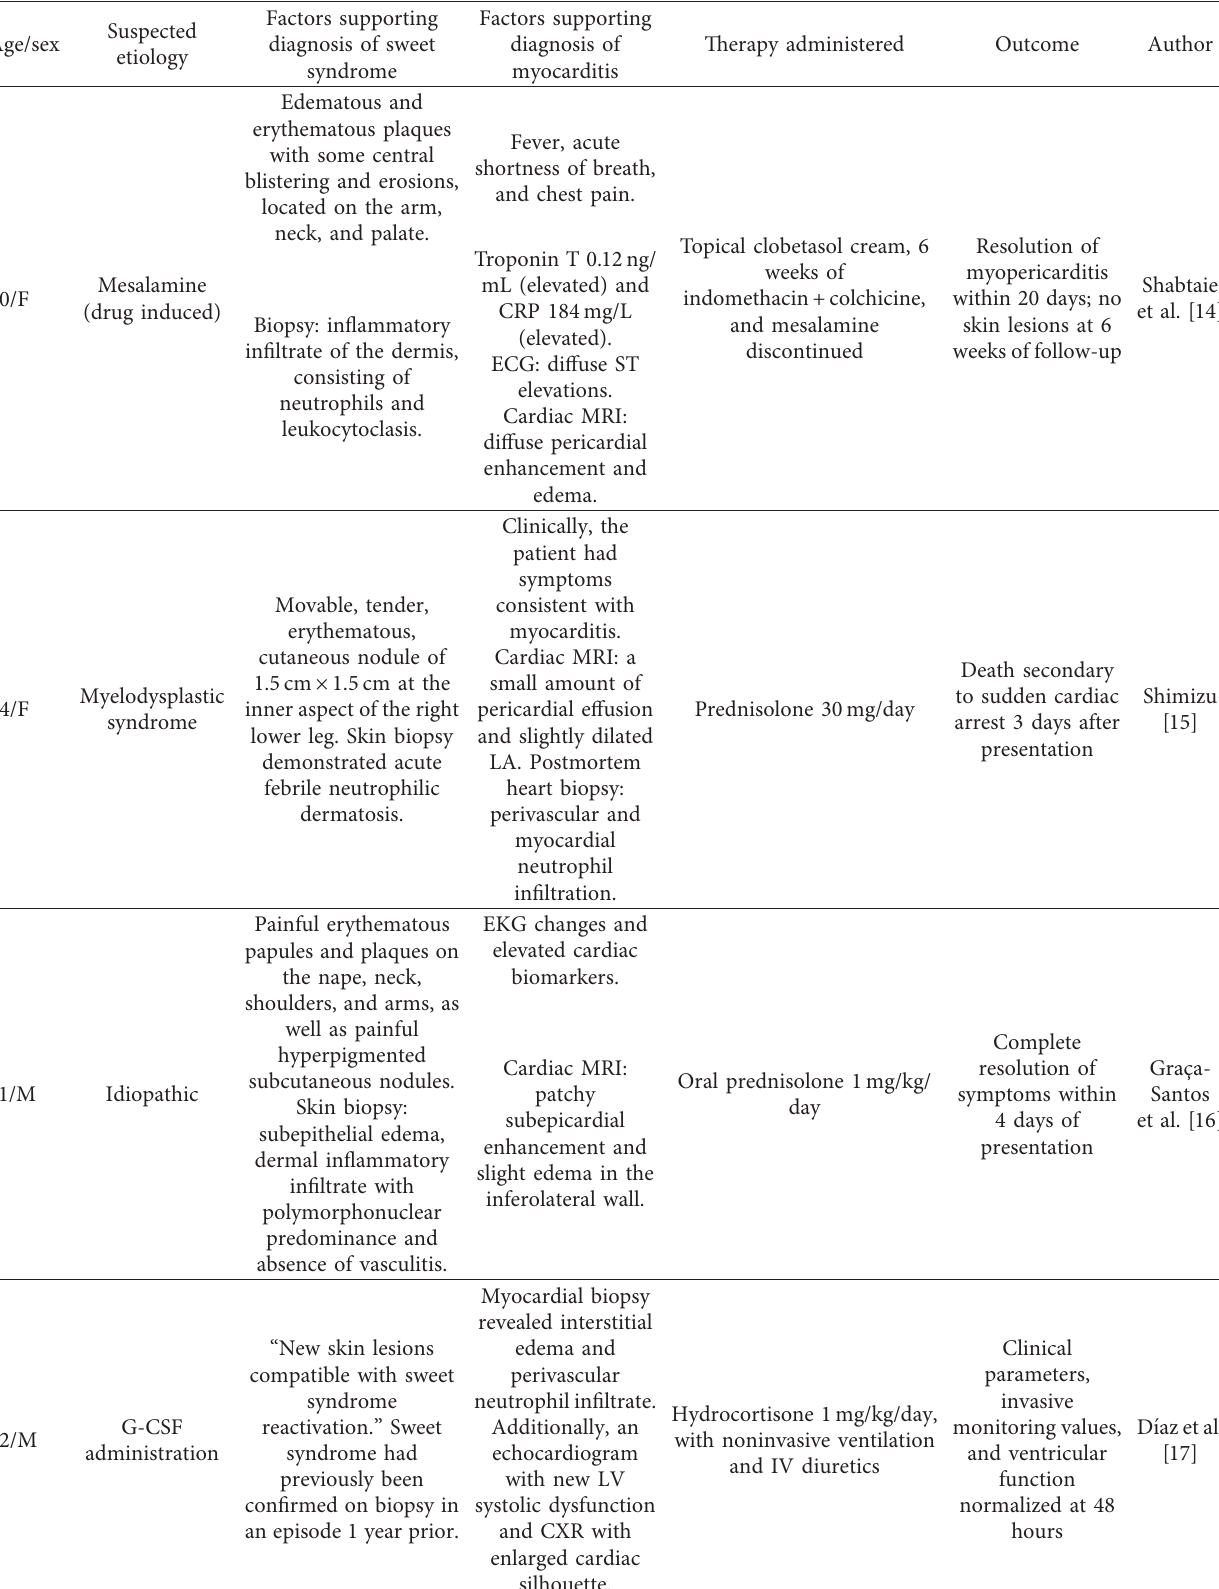
Table 2: Cases of sweet syndrome with concurrent